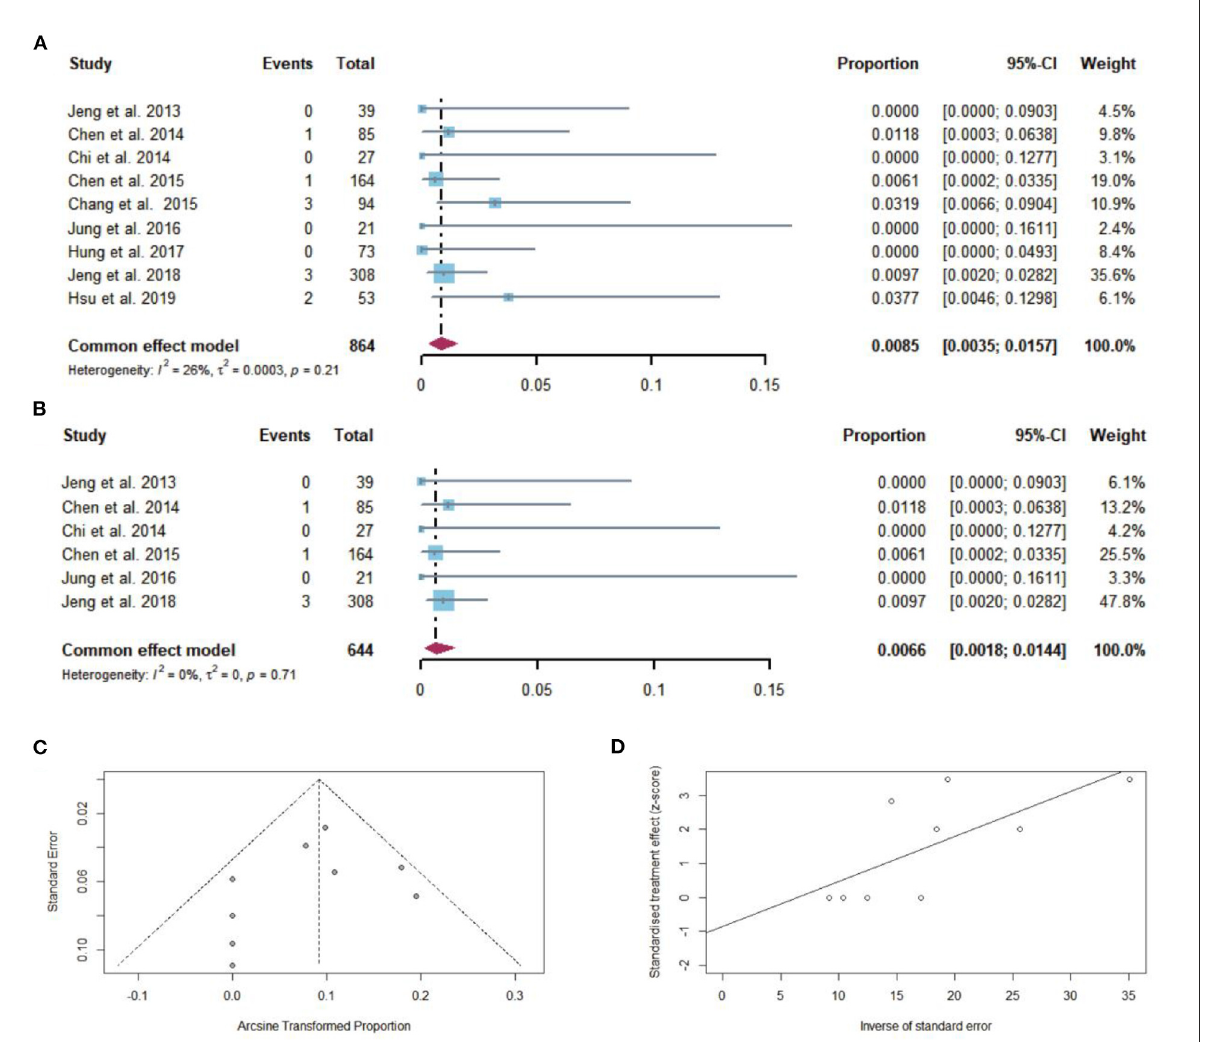
FIGURE8 (A) Individual estimates and pooled proportion of overall mortality in cirrhotic patients after NAs discontinuation. (B) Sensitivity analysis of pooled proportion of overall mortality in cirrhotic patients after NAs discontinuation excluding studies with high bias. (C) Funnel plot. (D) Egger’s